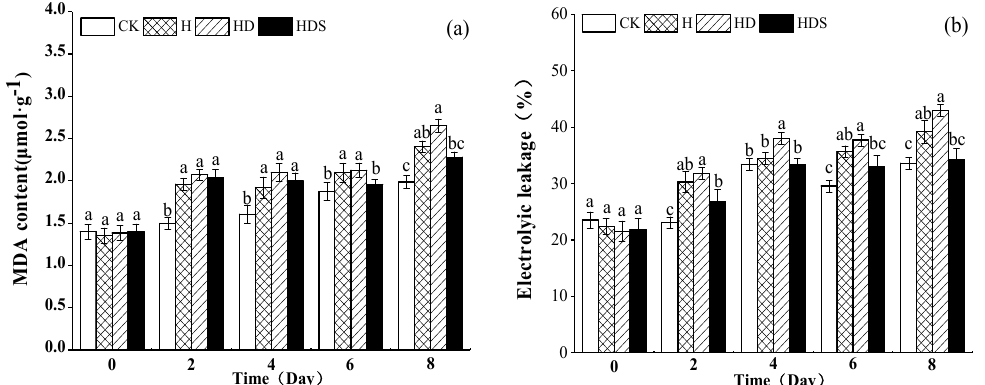
Figure 1. Effects of exogenous spermidine and D-arg on MDA content ( a ) and Relative electrolyte leakage ( b ) of lettuce under high-temperature stress. Vertical bars represent standard deviations of the mean ( n = 3). Values above each vertical bar followed by different letters show significant differences ( p < 0.05). CK, 22 ◦ C/17 ◦ C, deionized water; H, 35 ◦ C/30 ◦ C, deionized water; HD, 35